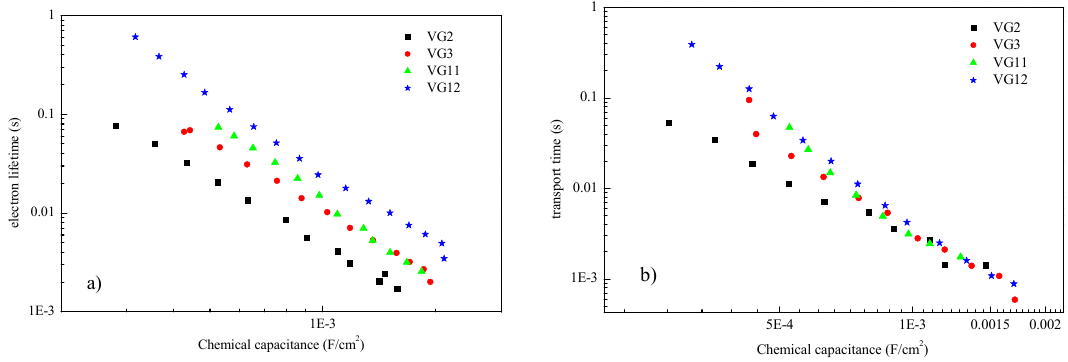
Figure 7. ( a ) Evolution of electron lifetime ( τ e ); ( b ) transport time ( τ tr ) as a function of device chemical capacitance (C μ ) for VG2 ‐ C8, VG3 ‐ C8, VG11 ‐ C8 and VG12 ‐ C8 dyes.